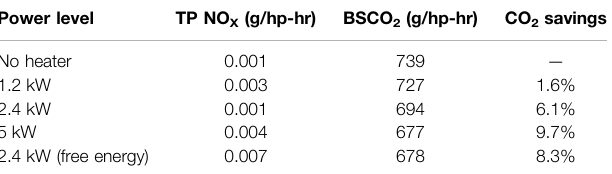
TABLE 10 | Beverage cycle